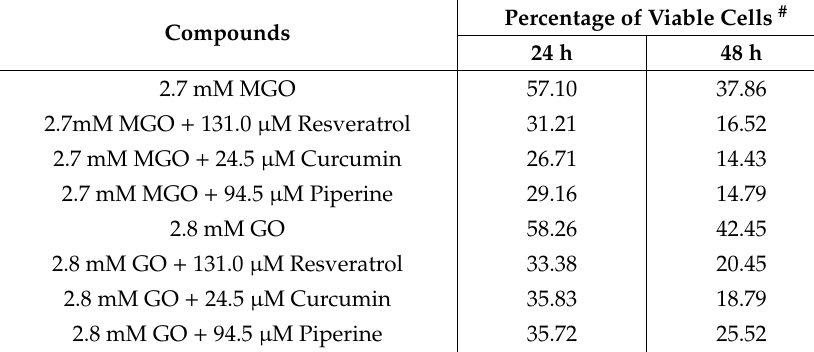
Table 1. E ff ects of resveratrol, curcumin and piperine associated with methylglyoxal and glyoxal on MCF-7 cell